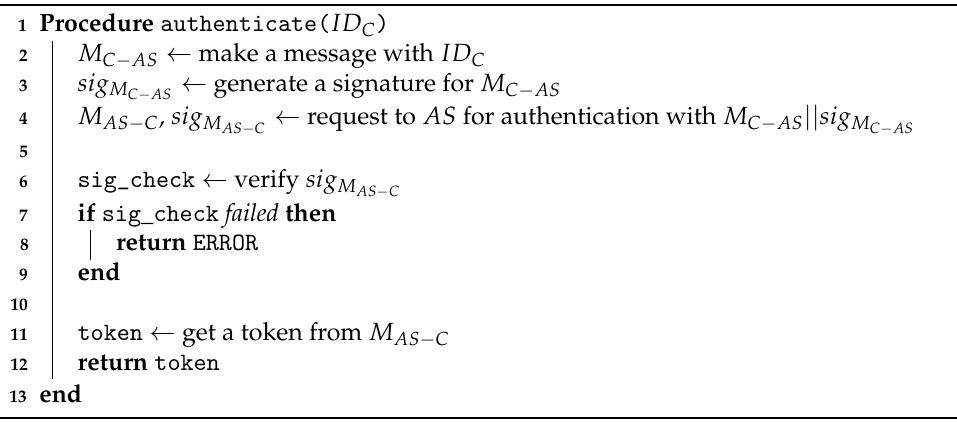
Algorithm 1: The authentication algorithm on the user side